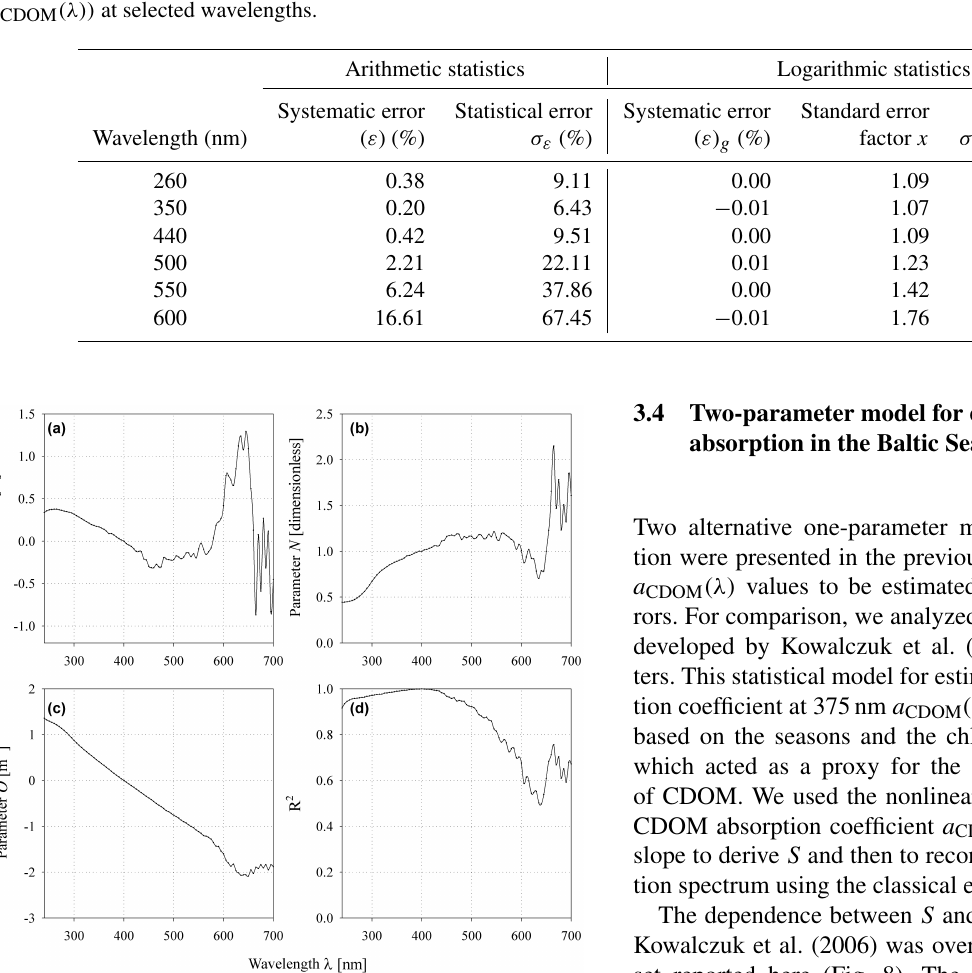
Figure 6. Spectral dependence of the model (expressed by Eq. 14) regression coefficients (a, b) , free term (c) and determination coef- ficient (d)